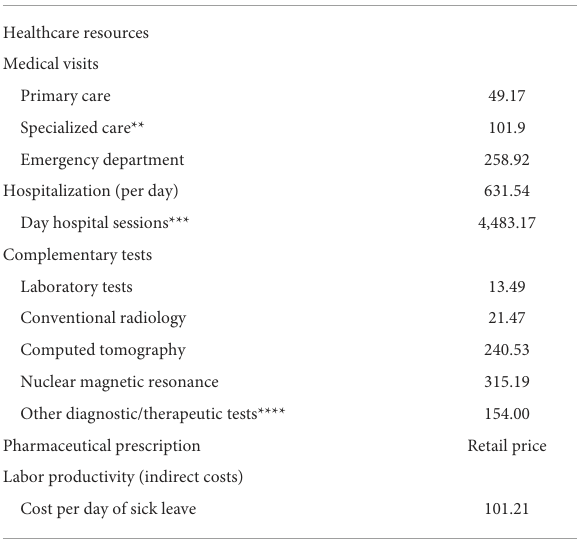
TABLE 3 Unit costs (year